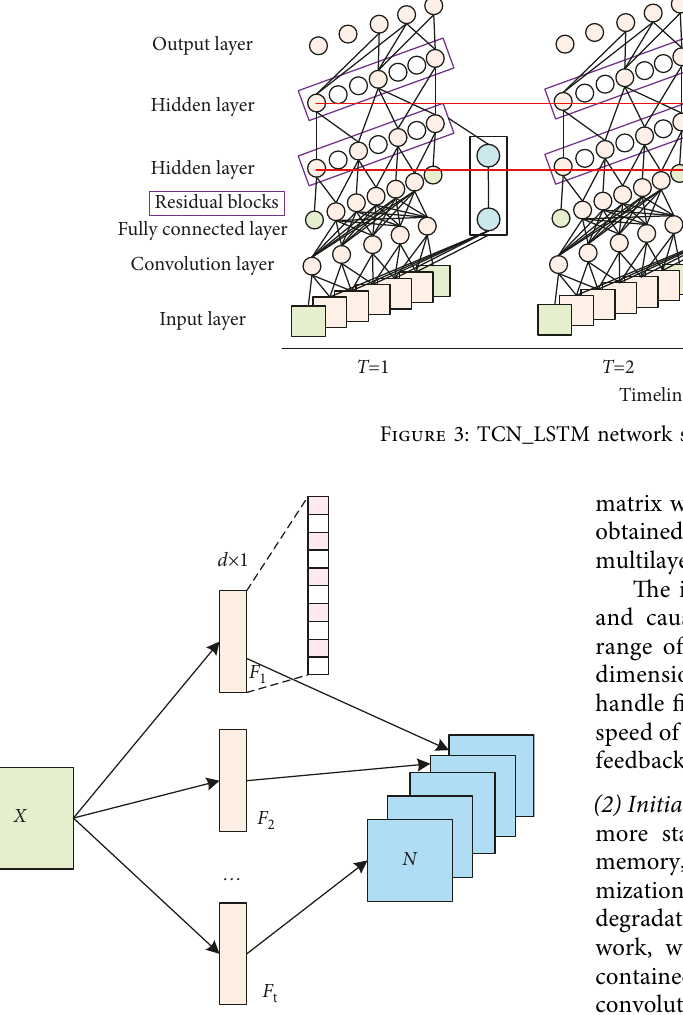
Figure 4: One-layer multiple one-dimensional expansion con- volution